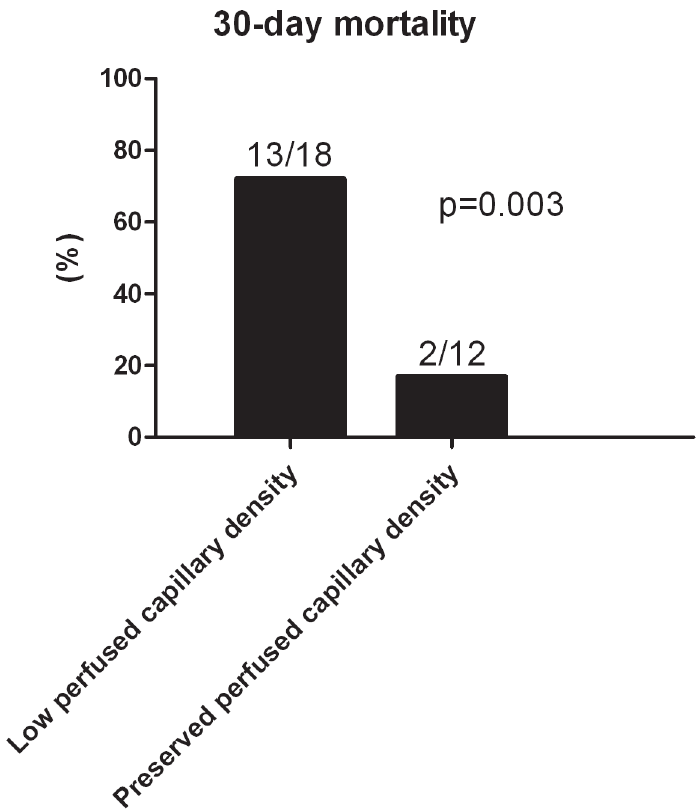
Figure 2. Thirty-day mortality according to final perfused capillary density. In the subgroup of patients (n=18) with low perfused capillary density (ie, # 10.3 mm.mm 2 2 ), 13 patients died, whereas in the subgroup of patients (n=12) with preserved capillary density (ie, . 10.3 mm.mm 2 2 ) 2 patients died (p=0.003).